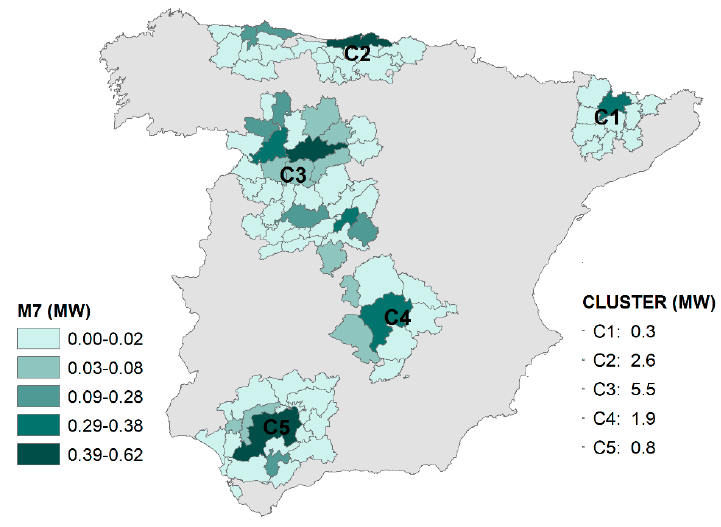
Figure 7. Geographical distribution of the power potential and clusters’ power for mixture M7.